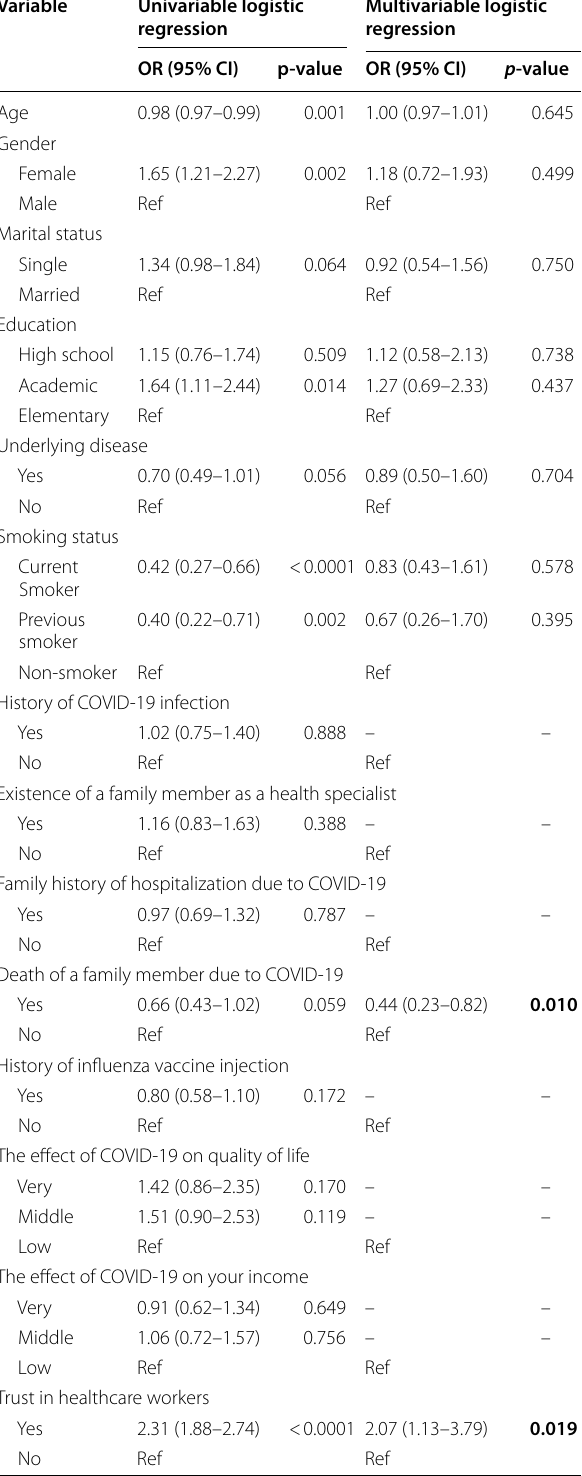
Table 2 Univariable and multivariable logistic regression modeling for the association between COVID-19 vaccine acceptance and several covariates (N =